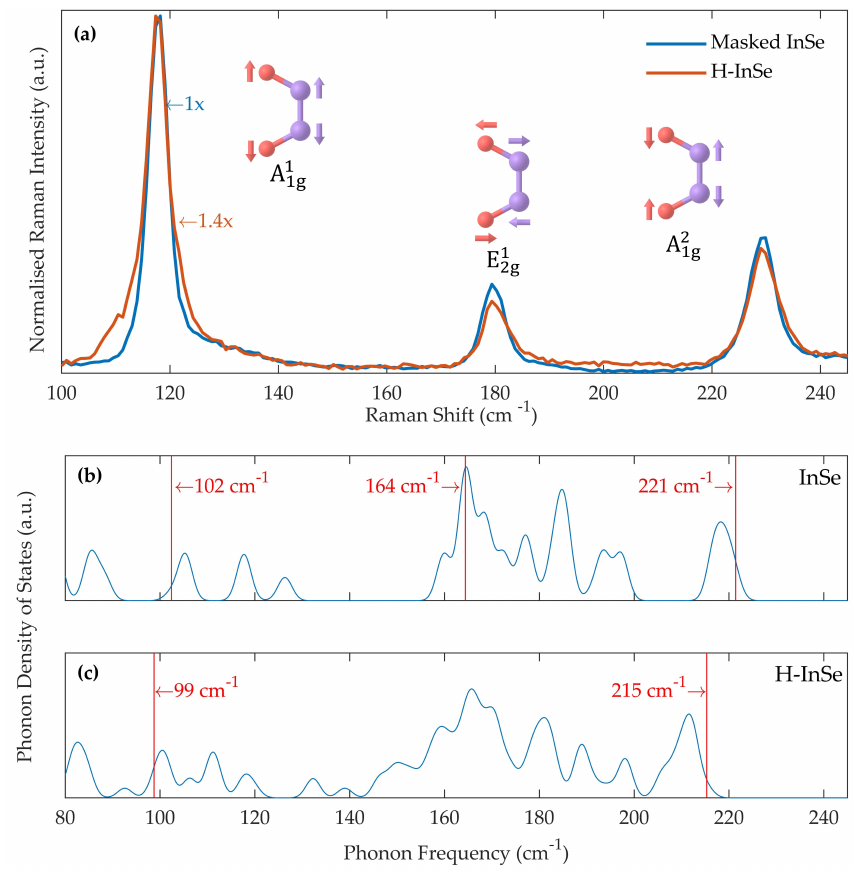
Figure 3. ( a ) Normalised Raman spectra of masked and hydrogenated (32 eV) γ -InSe, measured 12 days after hydrogenation ( λ = 532 nm, P = 0.2 mW, T = 300 K). The spectra are normalised to the first Raman peak. Insets: vibrational modes responsible for the three peaks. ( b , c ) DFT-calculated phonon density of states for: ( b ) a pristine InSe monolayer and ( c ) atomic hydrogen bonded to an InSe monolayer. These were calculated using a 4 × 4 × 1 supercell. The phonon density of states are Gaussian broadened with σ = 1.5 cm − 1 . Vertical red lines in ( b , c ) mark the position of Raman active modes, these correspond to the peaks in ( a